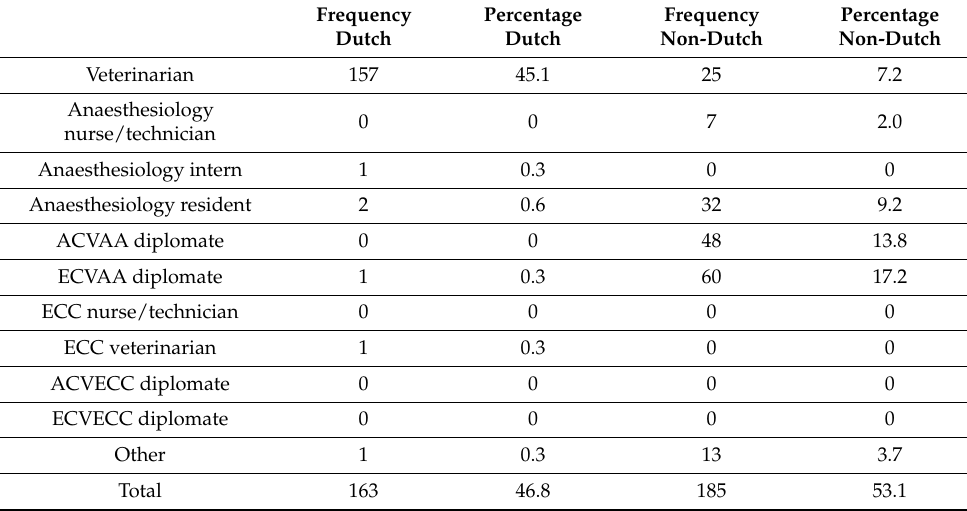
Table A10. Frequency and percentage of job title of Dutch compared to non-Dutch